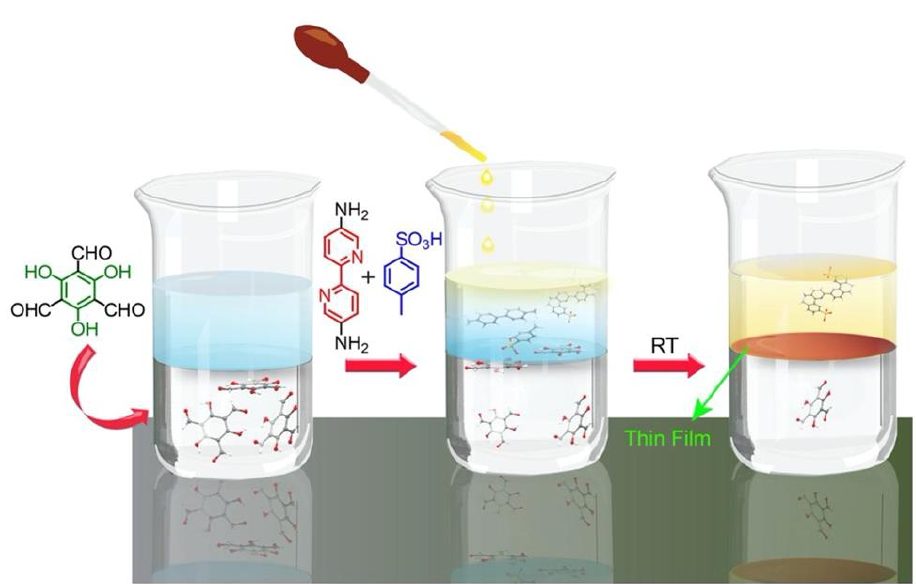
Figure 4. COF film formation via liquid-liquid interface method (Reproduced from Ref. [64] with permission from American Chemical Society).